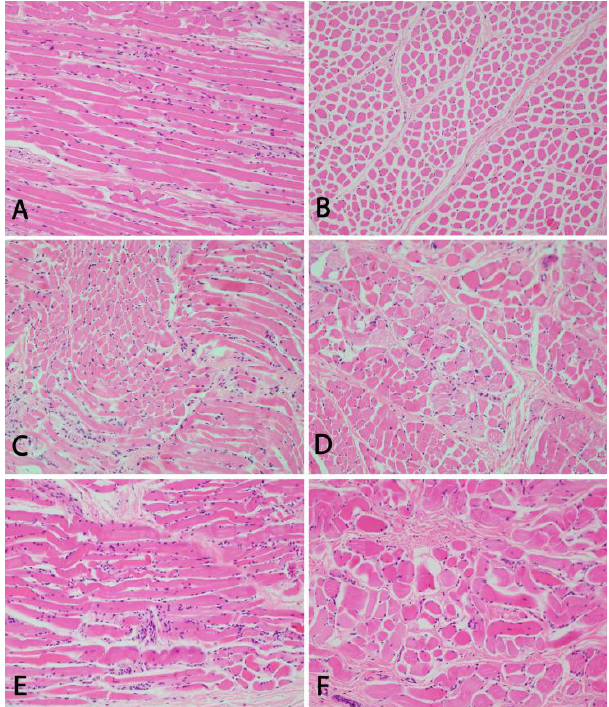
Figure 2. Histopathological features of BCSE-affected Holstein cattle. Longitudinal ( A ) and cross ( B ) sections of muscle fibers of the M. retractor bulb. The cross section ( B ) shows mild variation in size and cellular infiltrates. Longitudinal ( C ) and cross ( D ) sections of muscle fibers of the M. rectus lateralis show a moderate degeneration and atrophy with size variation of fibers. Severe degeneration with internalization of satellite cells and prominent variation in fiber size are seen in the longitudinal ( E ) and cross ( F ) sections of muscle fibers of the M. rectus dorsalis . 200× magnification, HE stain.